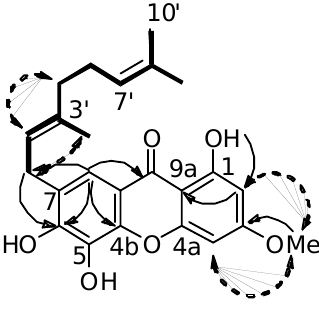
Figure 2. Key COSY (bold), HMBC (plain arrows) and NOESY (dashed arrows) correlations for 1